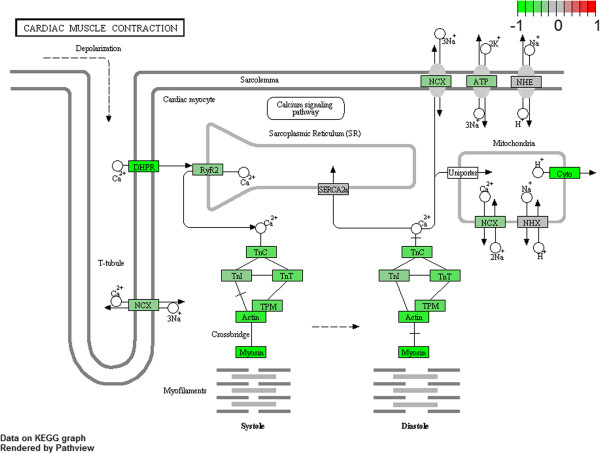
Cardiac muscle contraction pathway from KEGG. Genes are colored according to their GSEA calculated scores.